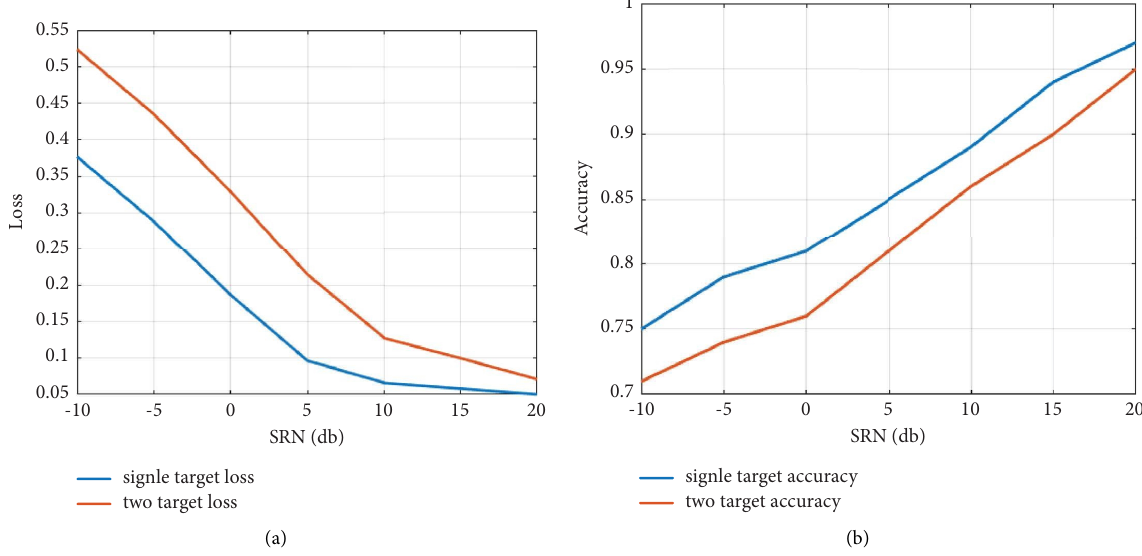
Figure 6: Comparison of accuracy and loss on test datasets for all single-target, two-target mode for diferent SNRs. (a) Loss diagrams. (b) Accuracy diagrams.